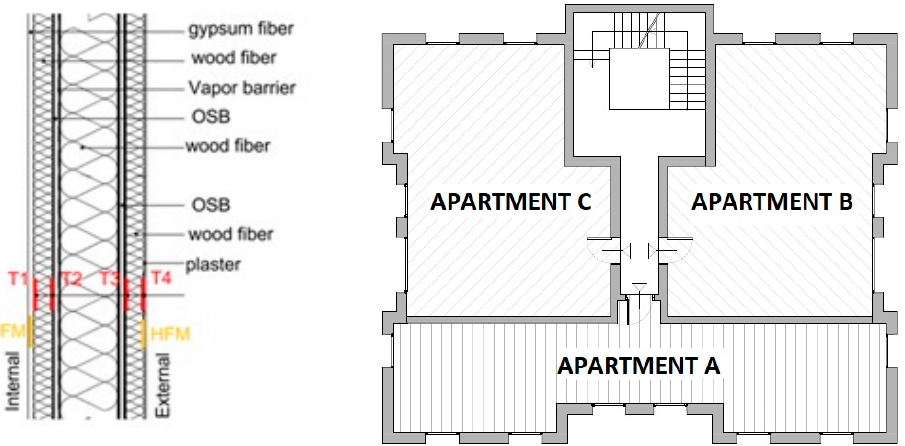
Figure 1. ( Left ) external wall stratigraphy and probes installed (thermocouples T1–T4 and heat flow meters HFM); ( right ) building floor layout and showing apartments A, B, and C.